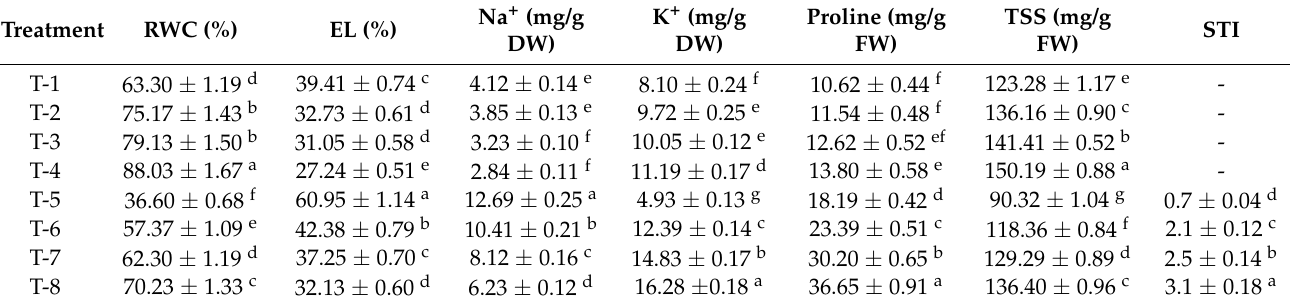
Table 2. Effect of PGPR and SNP on RWC, EL, ion content, proline, sugar content, and STI.